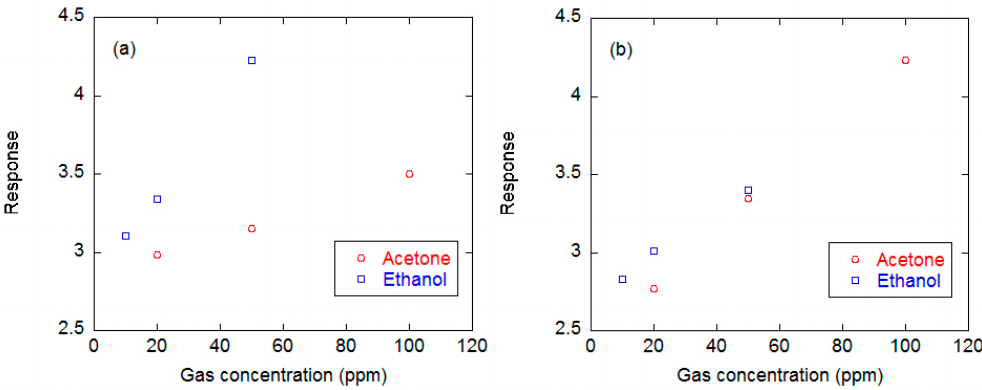
Figure 15. Calibration curves acquired with chemiresistors based on SnO 2 RGTO thin film ( a ) and nanowire ( b ) mounted in the EN against ethanol and acetone.